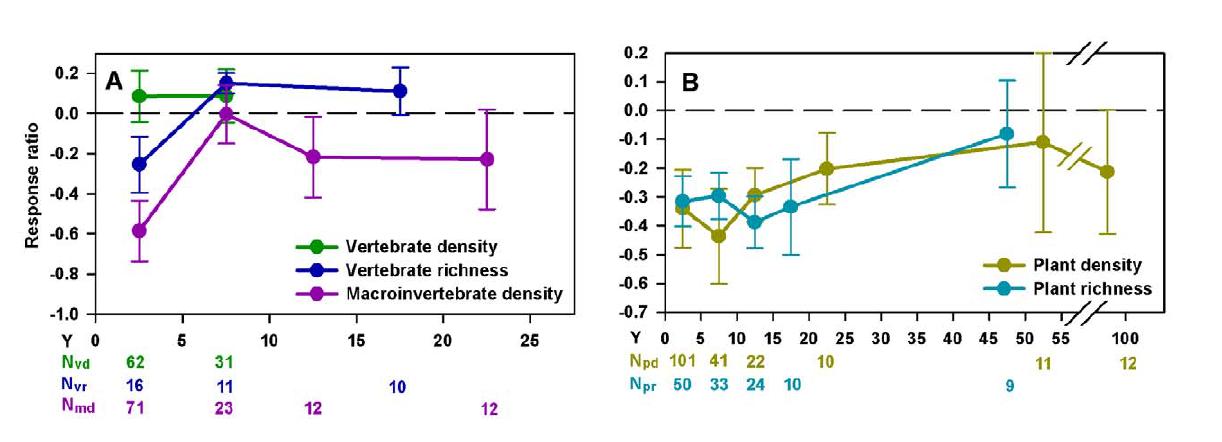
Figure 2. Recovery trajectories of animal and plant richness and density. Chronosequences of the means ( 6 standard error [SE]) of the response ratios (see Materials and Methods) of restored or created wetlands at successive age classes of 5 y or 10 consecutive y for vertebrates and macroinvertebrates density and richness (A) and for plant density and richness (B). Insufficient data points meeting our plotting criteria (see Materials and Methods) were available to plot for macroinvertebrate richness. The zero value dashed line represents reference wetlands (N, number of data points used to calculate the mean [ 6 SE] per age class; Y, years after restoration. Subscripts are as follows: md, macroinvertebrates density; pd, plant density; pr, plant richness; vd, vertebrate density; vr, vertebrates richness).